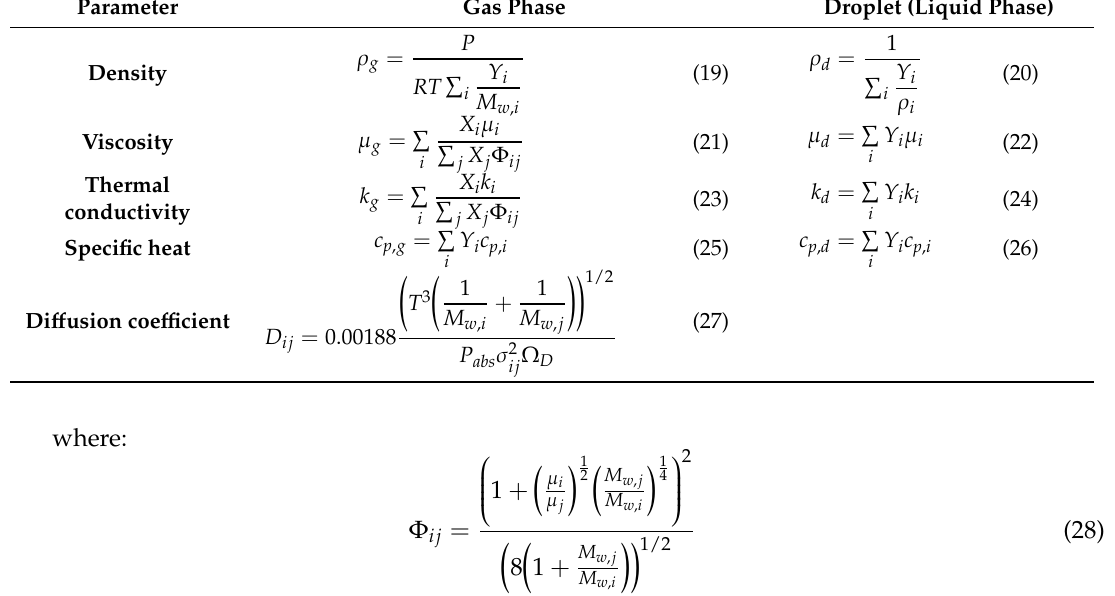
Table 3. Methods of calculating the physical properties of mixed gas and liquids used in this work. Parameter